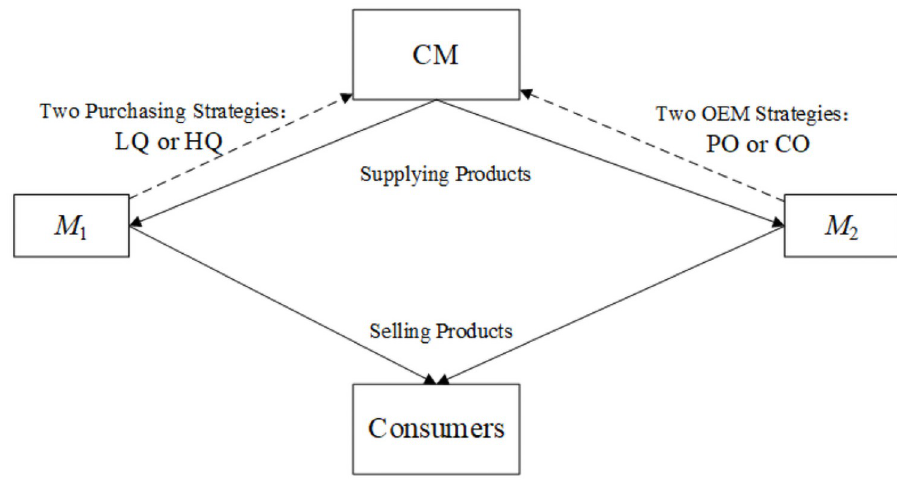
Fig 1. The relationship between the contract manufacturer and the original equipment